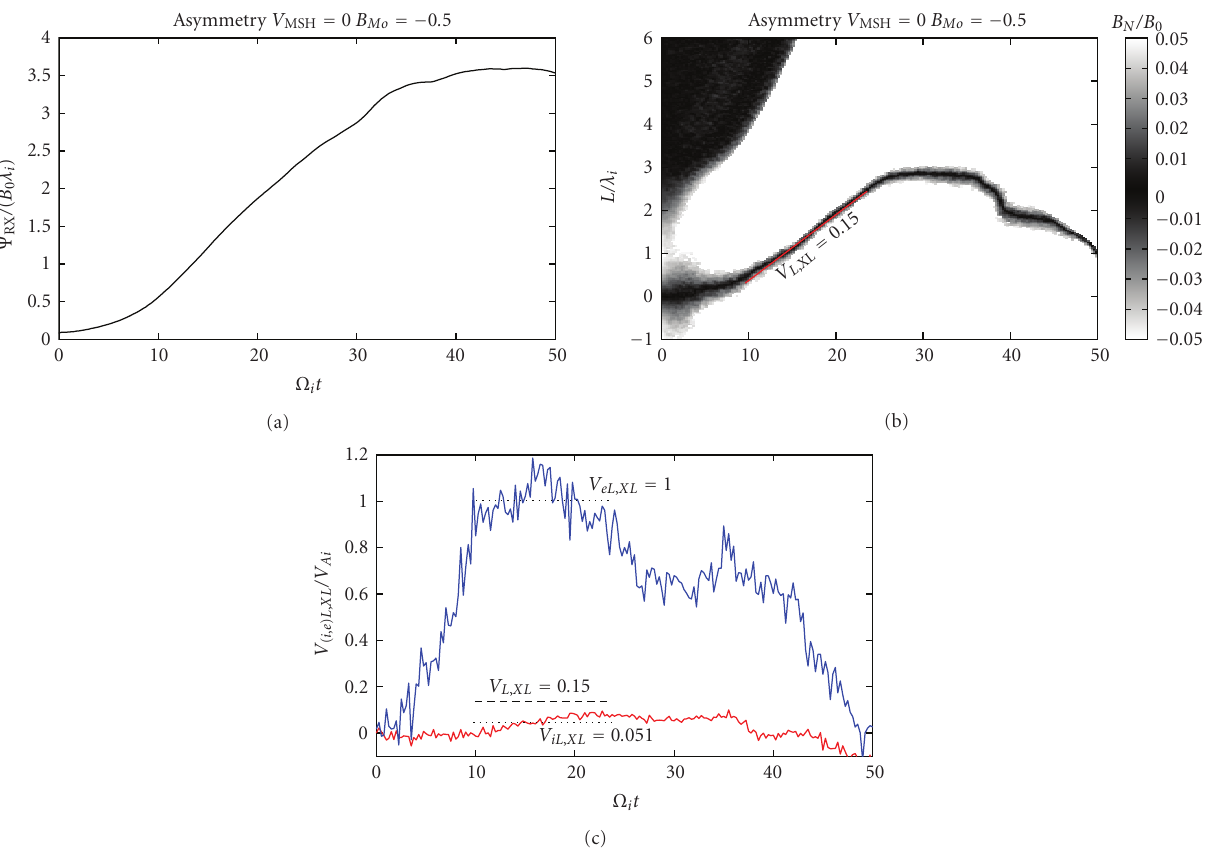
Figure 9: Results of the nonzero guide field B Mo = − 0 . 5 case without velocity shear ( V MSH = 0). (a) Growth of reconnection flux, (b) gray- scale contour of B N along the B L = 0 curve in the L -time diagram depicting the X-line motion, and (c) the X-line motion speed compared with ion and electron flow speed at the